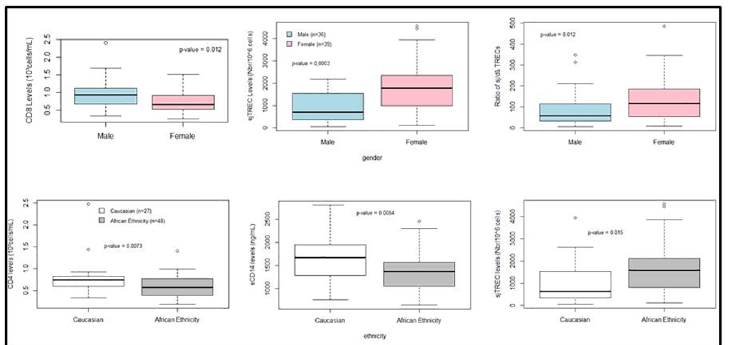
Fig 1. General comparison of data selected for the sex or the ethnicity. A. Impact of the sex on some observeddata. Men have higherCD8 (p = 0.012) levels but lower TRECsj (p = 0.0003) and ratio of TREC (p = 0.012) than women. B. Impact of the ethnicity. Caucasians have higherCD4 (p = 0.0073) levels and sCD14 (p = 0.0054) but lower TRECsj (p = 0.015) than peoplefrom African Origin.